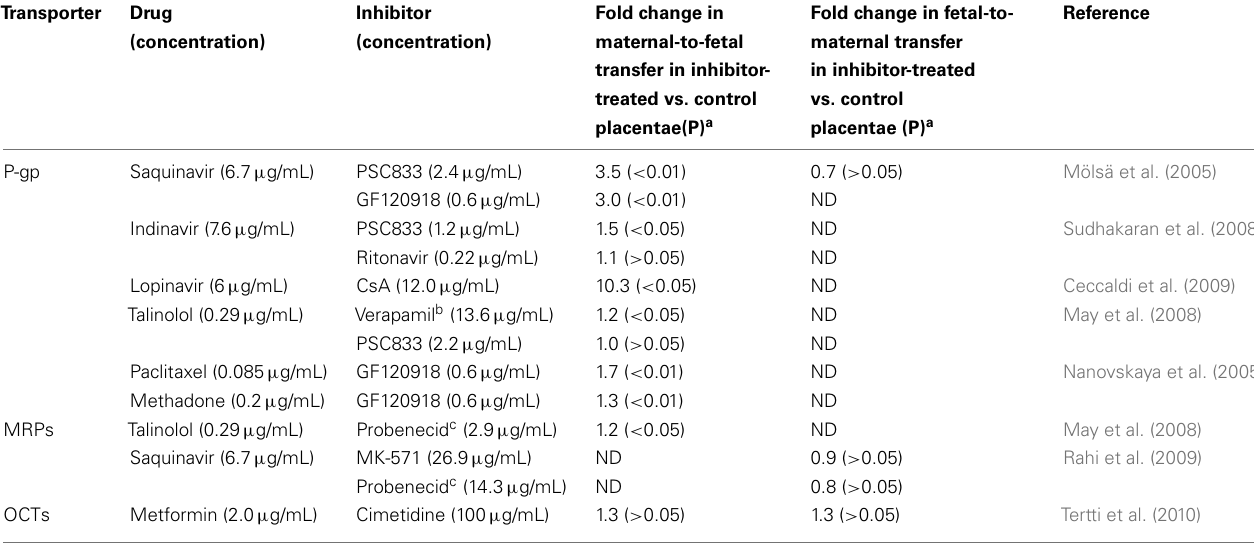
Table 1 | Effect of transporter inhibition on drug transfer across perfused term human placentae.